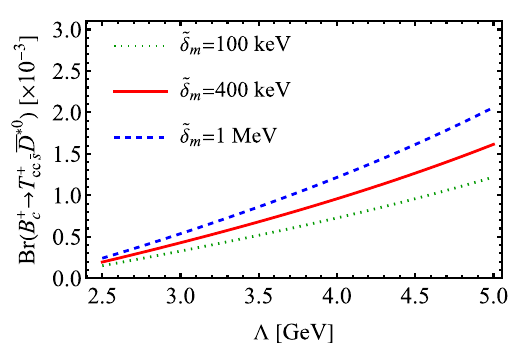
Fig. 7 (cid:6) -dependence of the branching ratio of B + c → T + rescattering processes in Fig. 5